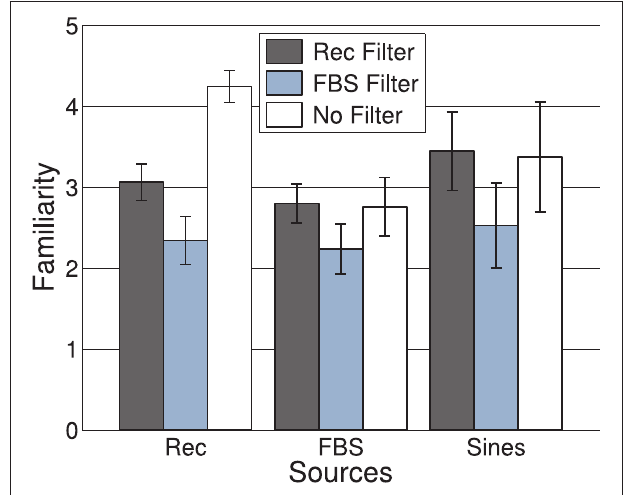
FIGURE 1 | Experiment 1: Mean familiarity of signals generated by nine different combinations of c-source (x-axis) and c-filter (color-coded), see text for a description of c-source and c-filter. Error bars represent 95% confidence